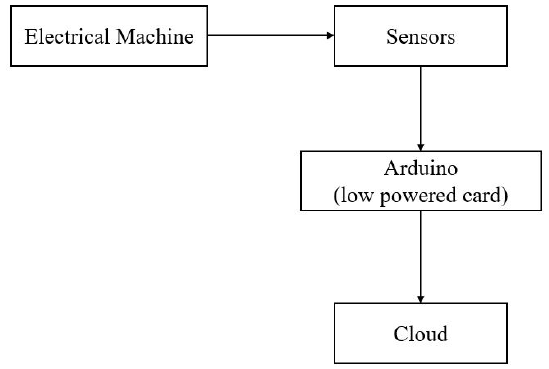
Figure 3. Flow chart for the data acquisition setup.